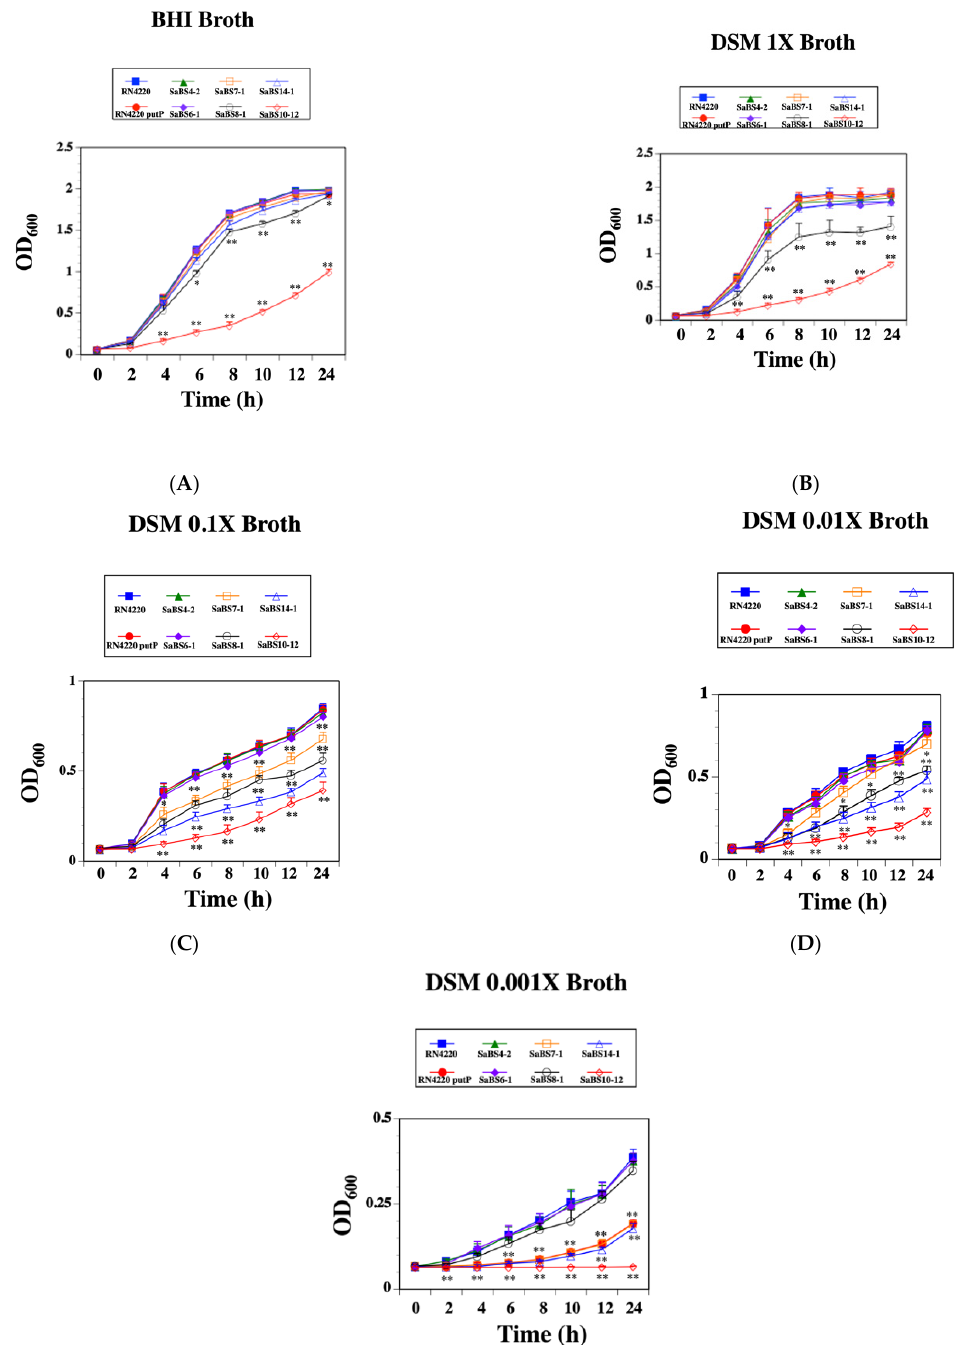
Figure 1. Growth curves of S. aureus RN4220 and derivatives in brain heart infusion broth (BHI) and defined staphylococcal minimal medium (DSM) with different proline concentrations. ( A ) BHI broth, ( B ) DSM 1× broth containing 1740 μ M proline, ( C ), DSM 0.1× broth containing 174 μ M proline, ( D ) DSM 0.01× broth containing 17.4 μ M proline, and ( E ) DSM 0.001× broth containing 1.74 μ M proline. The strains tested were wild type (closed blue square), RN4220 putP ( putP mutant, closed red circle), SaBS4-1 (closed green triangle, proP mutant), SaBS7-1 (closed purple diamond, opuD mutant), SaBS6-1 (open orange square, proP putP mutant), SaBS8-1 (open black circle, opuD proP ), SaBS14-1 (open blue triangle, opuD putP mutant), and SaBS10-12 (open red triangle, opuD proP putP mutant). The data represent the mean + standard deviation from at least three separate experiments. * p < 0.05 and ** p <